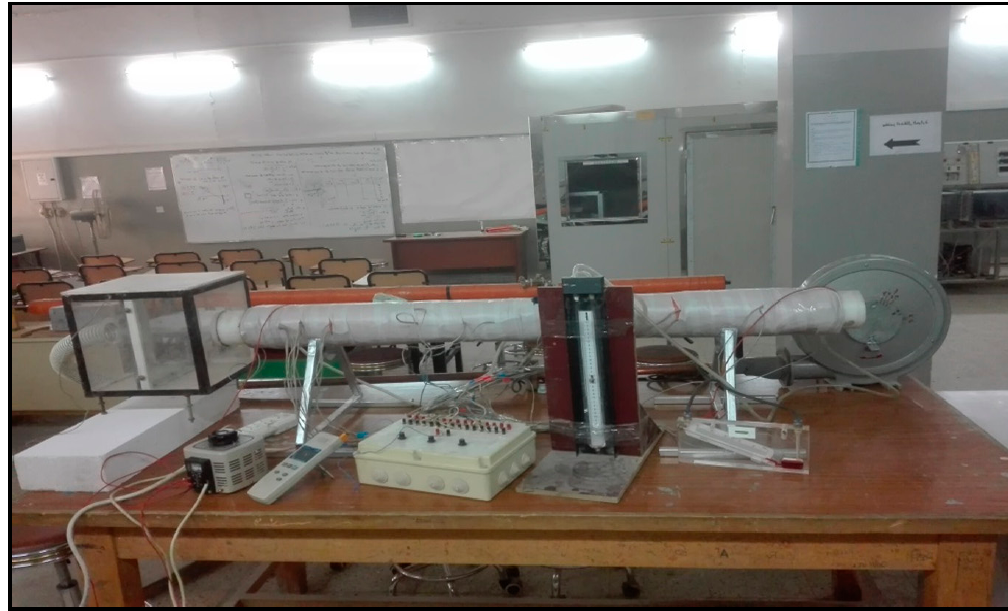
Figure 1. Photographic view of the using experimental apparatus.